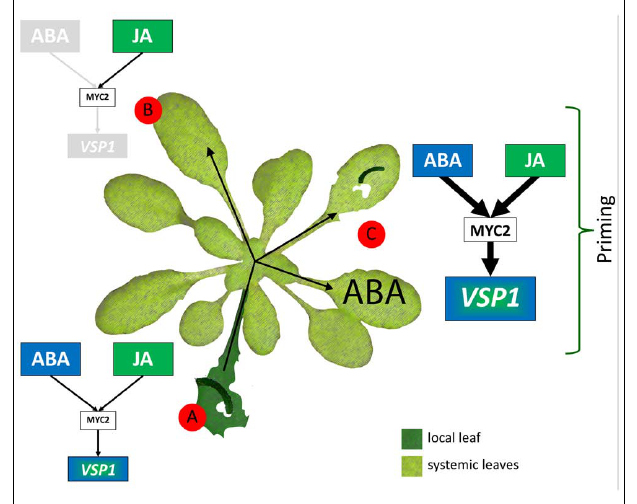
FIGURE 5 | Model of differential JA responses induced in local damaged and systemic undamaged leaves upon P. rapae feeding. (A) Upon P. rapae feeding, local damaged leaves show upregulation of JA/JA-Ile and ABA levels and of transcriptional activity of the MYC-branch regulator gene MYC2 and its downstream response gene VSP1 . (B) In systemic undamaged leaves of P. rapae -infested plants, the level of JA/JA-Ile and MYC2 gene expression is upregulated. However, the level of ABA and MYC-regulated VSP1 transcription is not increased. (C) Challenge of MYC-primed systemic undamaged leaves with either P. rapae larvae or exogenously applied ABA leads to potentiated transcript levels of MYC2 and particularly VSP1 , which are much higher than those observed in local infested leaves. Furthermore, P. rapae performance is reduced if plants were previously infested.This indicates that undamaged tissue of P. rapae -infested plants is primed for enhanced defense against subsequent P. rapae attack and that ABA production induced upon subsequent infestation is important for the onset of potentiated expression of the MYC-branch of JA